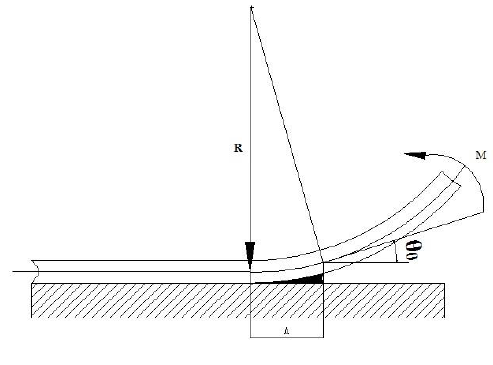
Figure 9. Schematic diagram of θ 0 . Table 5. Results of the tensile testing of T-type SS304 / BNi-2 brazed